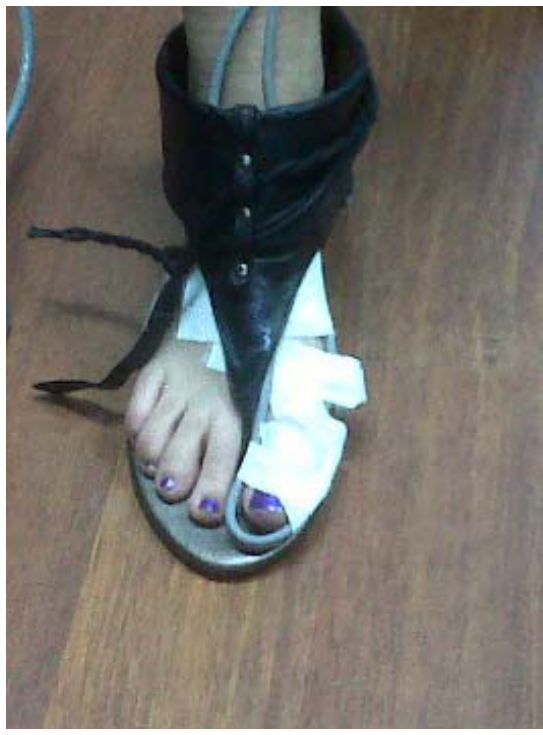
Figure 4. Fastening of the sensors. White bandages are auto ‐ adhesive fixatives.